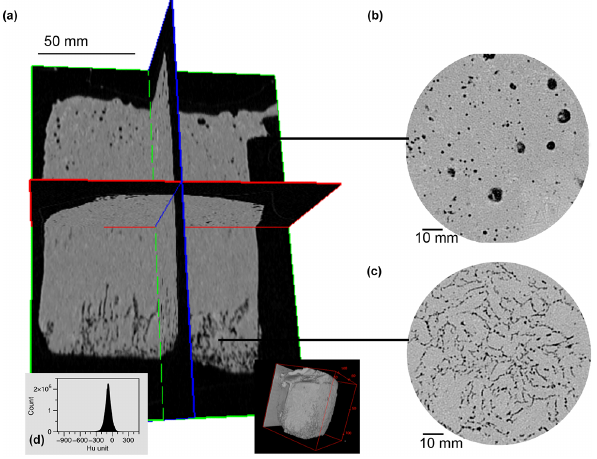
Figure 1. (a) 3-D orthoslice view from raw images of 16 Jan- uary, consisting of two longitudinal slices and one transversal slice, lighter grey represent the ice matrices and black area represent the air inclusions (i.e., bubbles); (b) top transversal slice at 0.65mm depth, every black dot represents an air inclusion (i.e., bubbles); (c) bottom transversal slice at 8cm depth, all the black dots show drained brine; (d) histogram of HU-unit (Ct-value) recorded for 186 transversal slices of 0.6mm thick for 16 January.